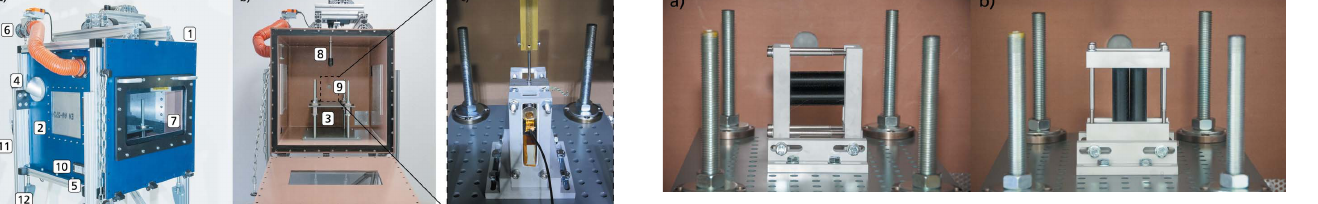
Figure 2 Pictures of the battery testing chamber, showing in ( a ) the outside of the chamber, with the extraction tube and valve visible, as well as the polished X-ray aluminium windows, and the opening for the thermal camera. In ( b ) the inside of the chamber with the sample table and nail piston is visible. The cell holder which is placed on top of the sample table is depicted in ( c ) with the nail going through the guiding hole and the cells mounted inside the cell holder.